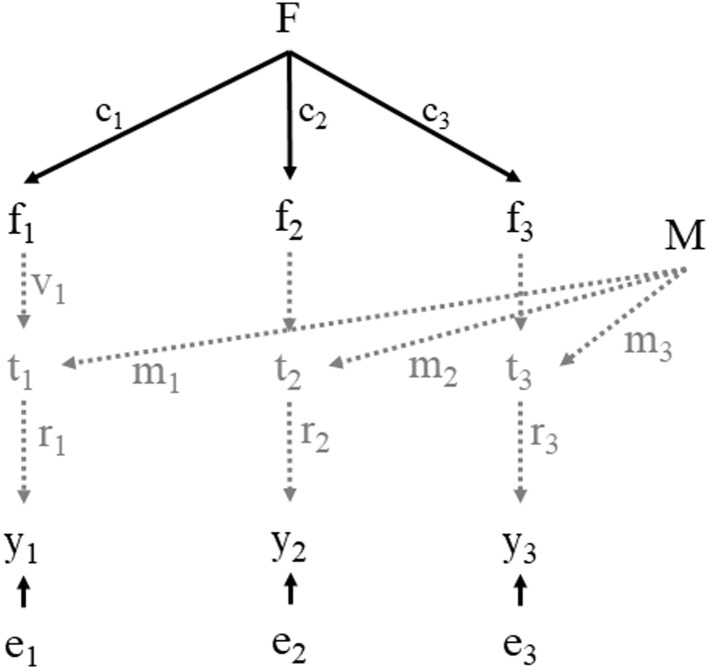
Factor model with three indicators and the separation of cognitive and measurement part.